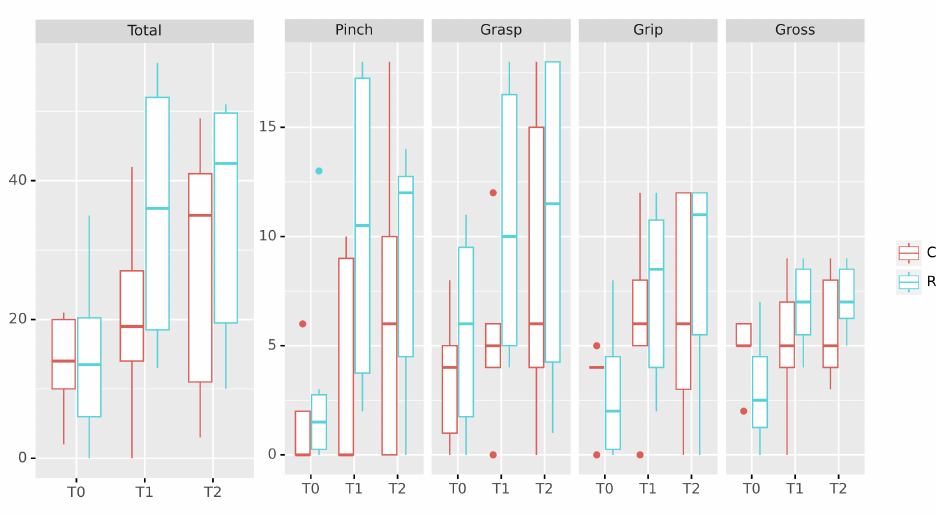
Figure 4. ARAT scores changes Results of treatment. Top: boxplot with patients scores for each ARAT subscale. Bottom: variations if each patient shown as a lineplot. Group assignment by hue; C: Control group, R:RETRAINER S2 group. Assessment performed at inclusion (T0), end of treatment (T1) at week 9, and follow-up assessment (T2) at week 13. The experimental treatment effect appears provide a significant onset within the in-treatment